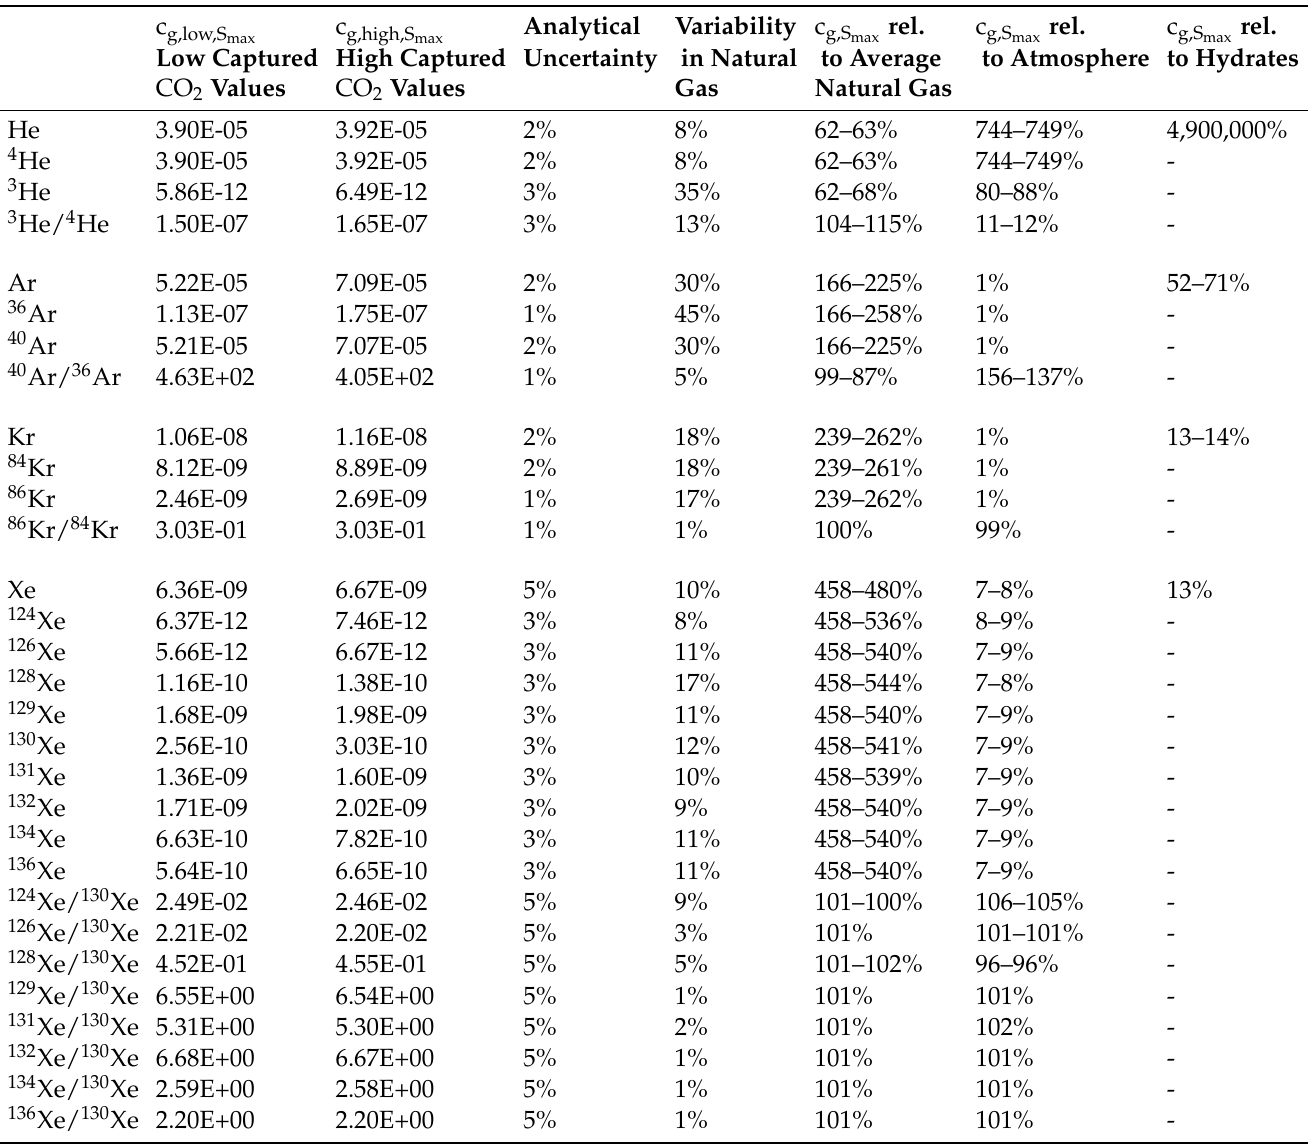
Table 3. Noble gas concentrations in cm 3 /cm 3 and isotopic ratios after equilibration with formation water for low and STP STP high concentrations in captured CO 2 , as in Table 1. Analytical uncertainty and natural gas variability from the Sleipner field in [28]. Concentrations and ratios are relative to the respective background fluids; the stated ranges are for c g,low,S c g,high,S , max